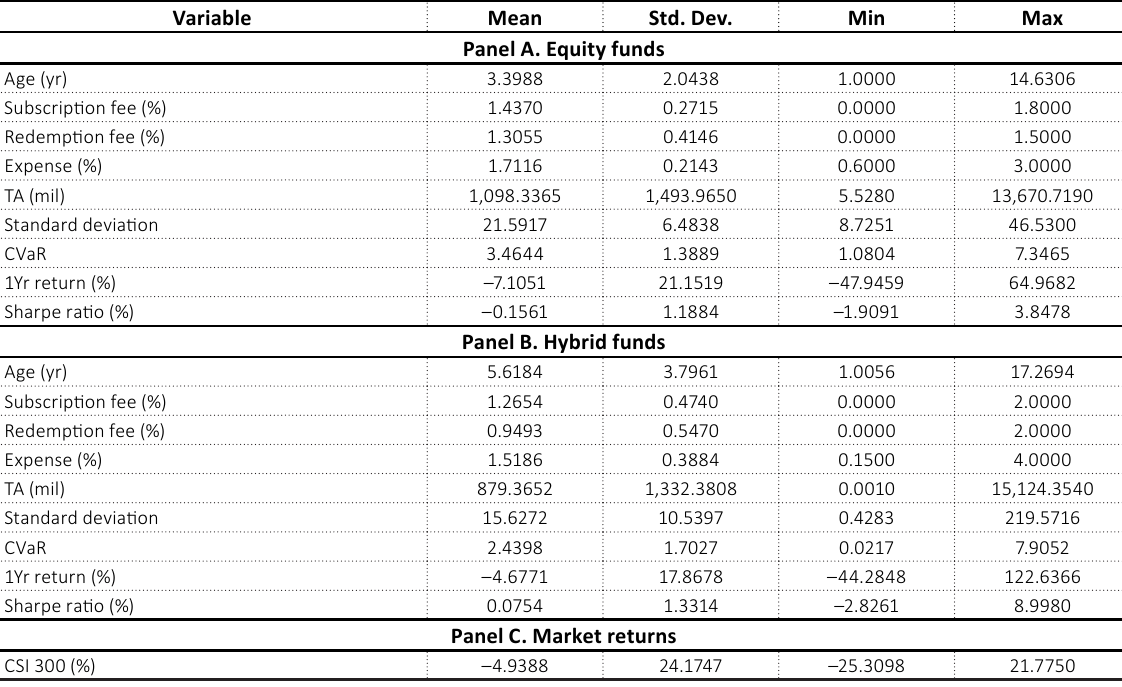
Table 1. Descriptive statistics of Chinese equity and hybrid funds for